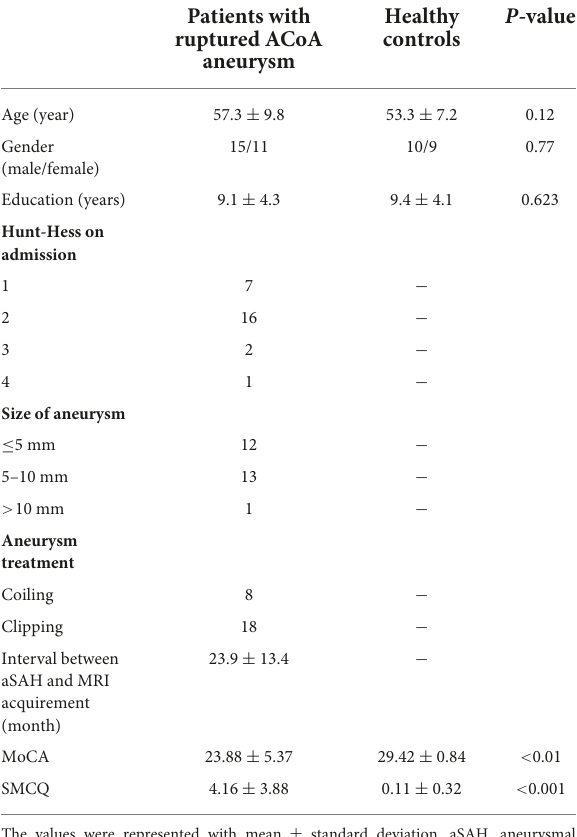
TABLE 1 Clinical characteristics of the patients with ruptured ACoA aneurysm and healthy